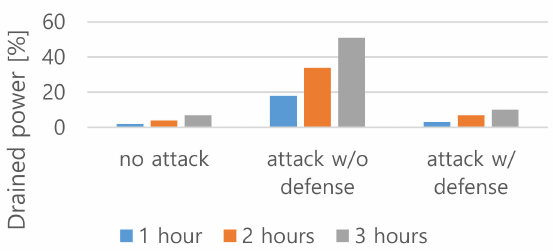
Figure 8. Evaluation results on the Wi-Fi power switching